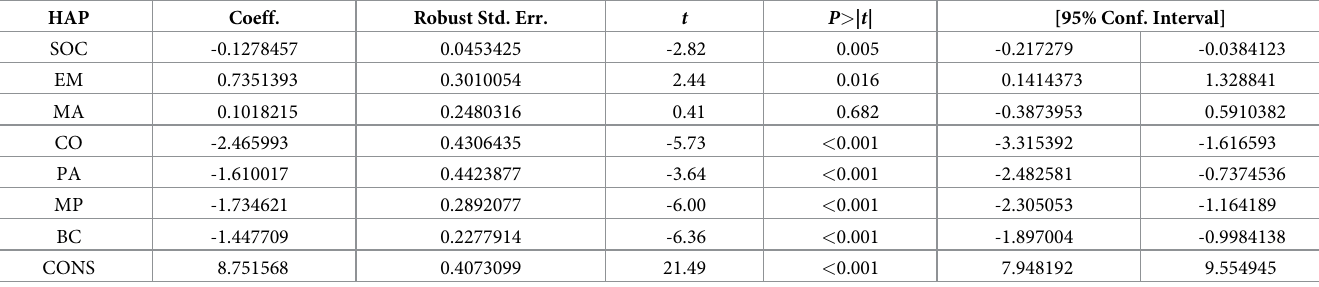
Table 3. The empirical estimation of the individual happiness (HAP) costs for social benefits (SOC) using Eq 5. HAP Coeff. Robust Std. Err.